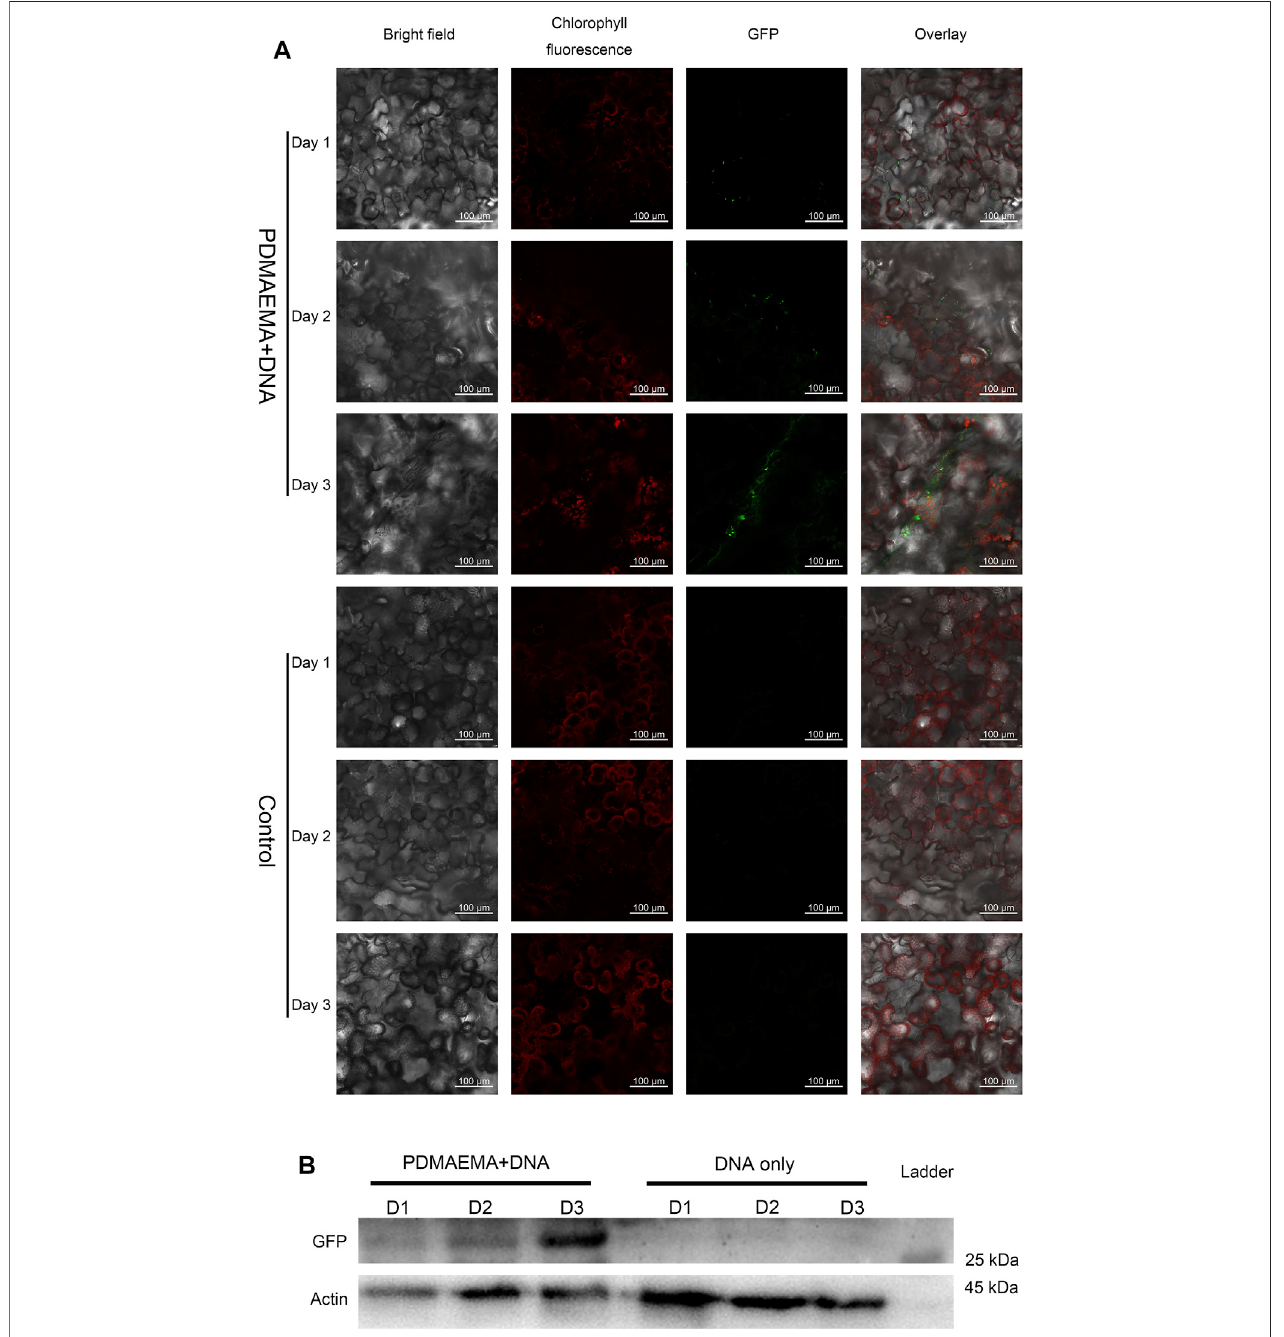
FIGURE 4 | GFP expression in Nicotiana benthamiana leaves. (A) Nicotiana benthamiana leaves in fi ltrated with DNA only (in 10 mM MgCl 2 /MES as a control) and PDMAEMA+DNA(N/Pratioof15:1)areimagedusingaconfocalmicroscopetodetectGFPexpressionintheleaflaminain1day,2 days,and3 days.Experimentswere performed with intact leaves from healthy plants. Scale bar, 100 μ m. (B) Western blot of GFP expression of Nicotiana benthamiana leaves in fi ltrated with DNA only (in 10 mM